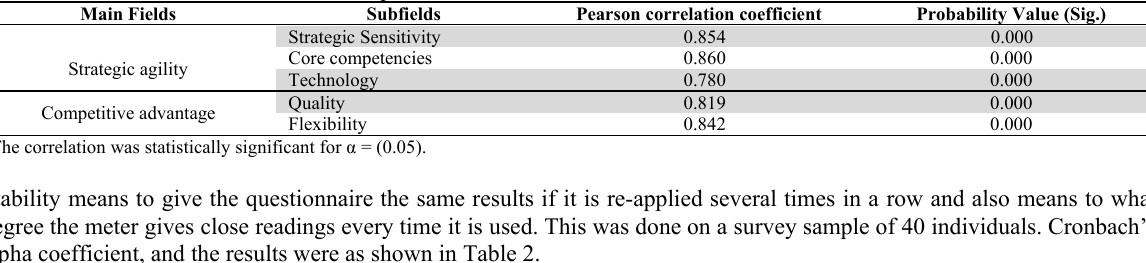
Correlation coefficients in all field of the questionnaire Main Fields Subfields Pearson correlation coefficient Probability Value (Sig.) Strategic Sensitivity 0.854 Strategic agility Quality 0.819 Competitive advantage